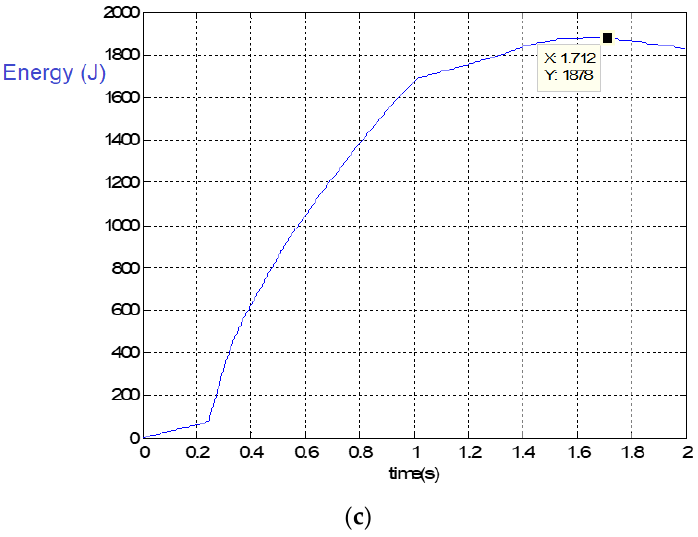
Figure 2. Cranking test results conducted on a Ford Focus 2013: ( a ) cranking voltage and current profiles, with voltage in volts (green) and current in amps (blue); ( b ) instantaneous power profile in watts; ( c ) energy profile energy in joules.